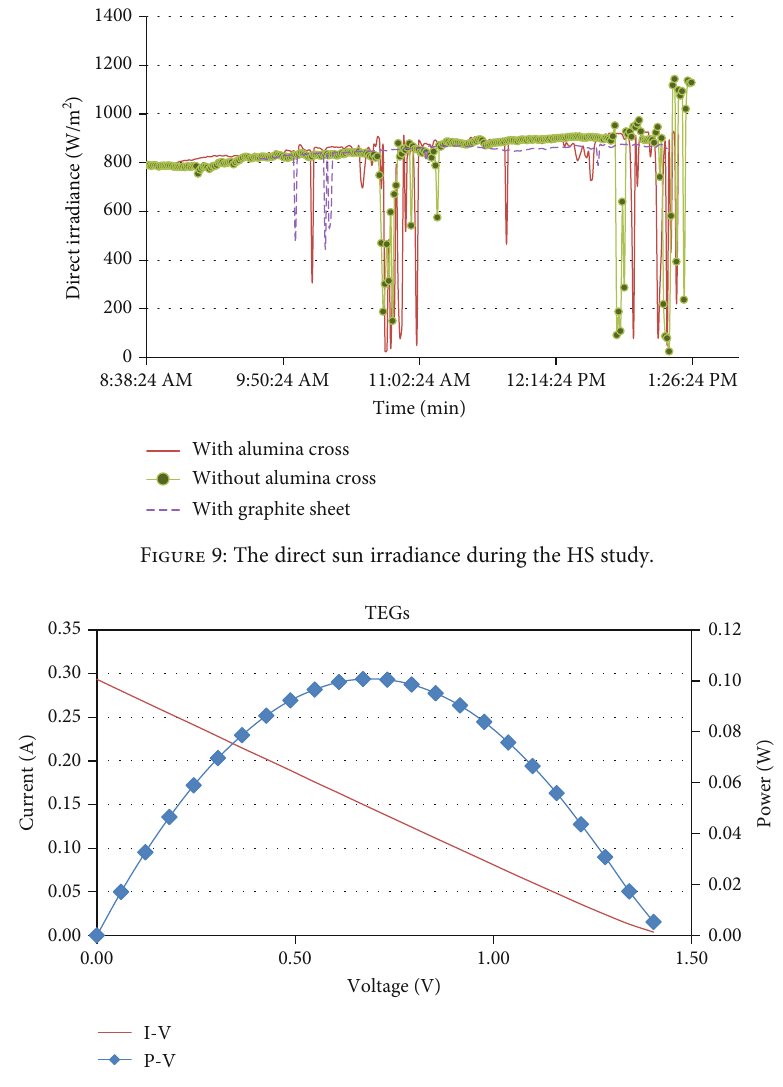
Figure 10: The I-V and P-V characteristics of TEGs in concentrated sunlight (25 suns, at Δ T = 25 °